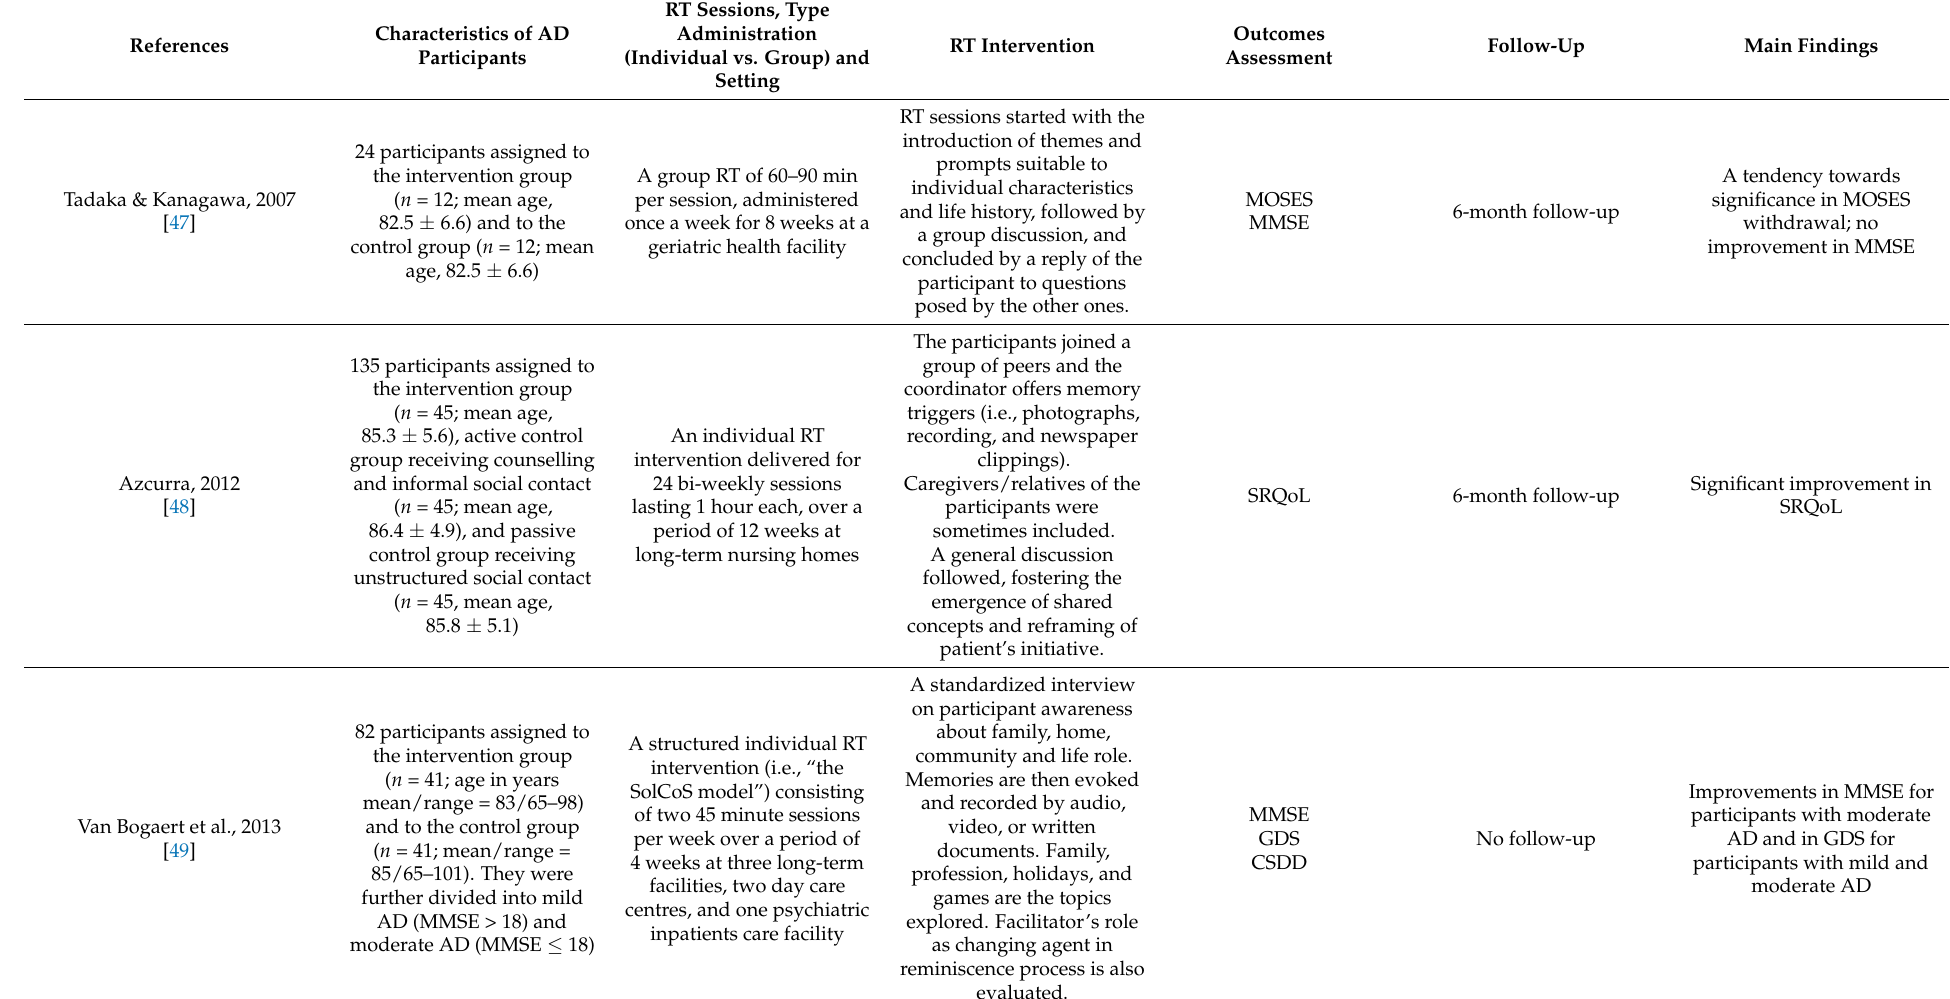
Table 3. Synthesis of main